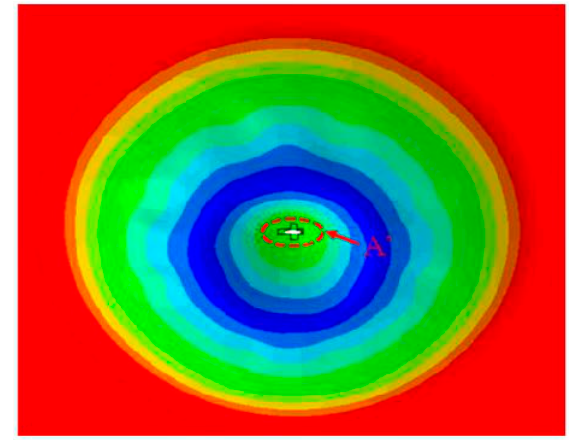
Figure 19. The fracture result of high-speed electromagnetic impaction with the GTN model.